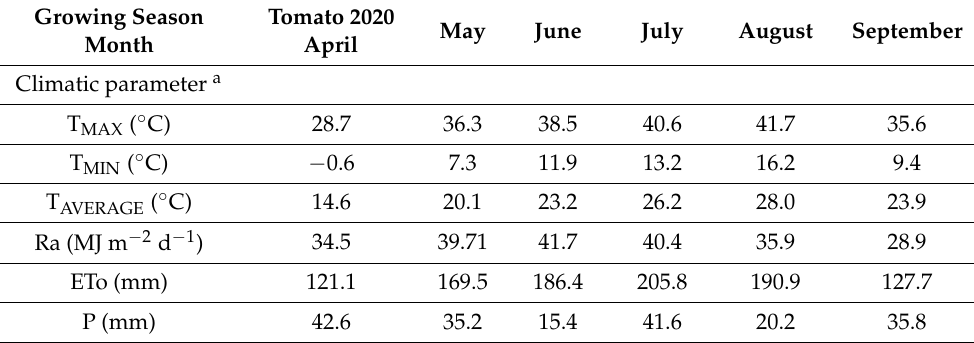
Table 1. Climatic parameter recorded during the irrigation season of the tomato during 2020 in the Stornarella gauge station.